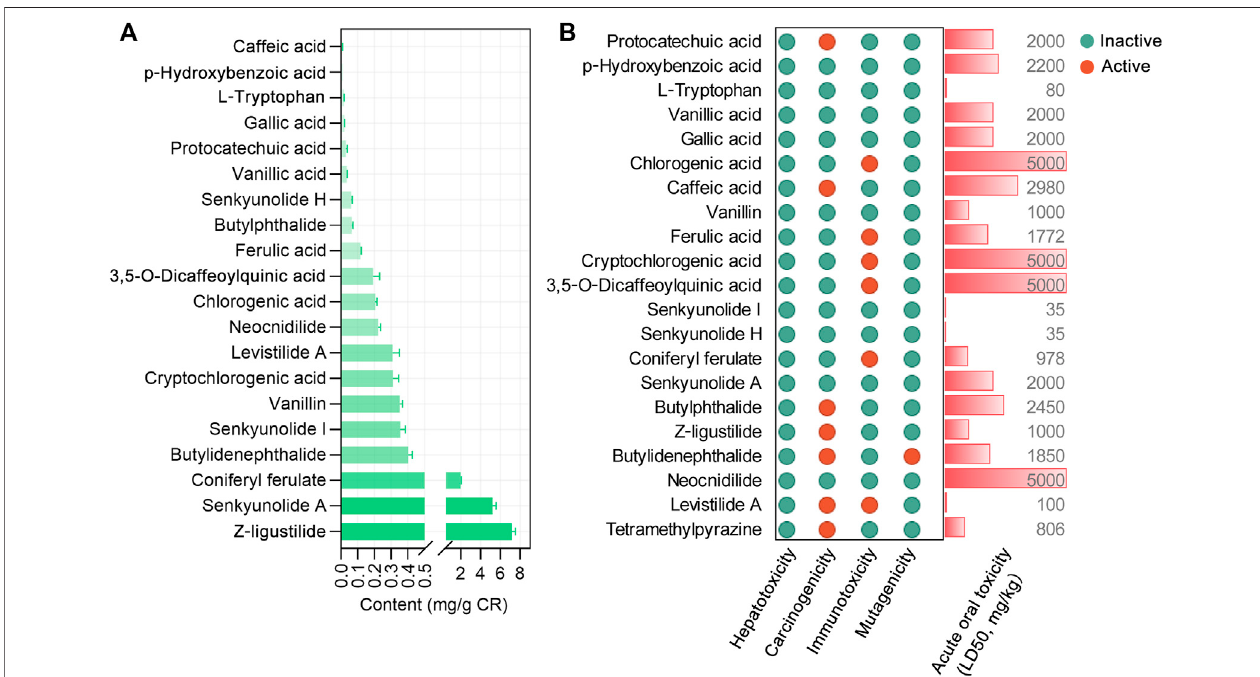
FIGURE 1 | The content and toxicological parameters of bioactive phytochemicals in Chuanxiong Rhizoma (CR). (A) The contents of chemical constituents in CR dried rhizome samplesfrom different origins in the Sichuan Province, China. The data were derived from in arecent report (Wang et al., 2020) and expressed as mean ± standarderrors ofthemean (SEM). (B) Thetoxicologicalparametersof21phytochemicalsin CR,such ashepatotoxicity,carcinogenicity,immunotoxicity, mutagenicity, and acute oral toxicity (LD50, mg/kg). The red and green circles represent active or inactive toxicological end points, respectively.